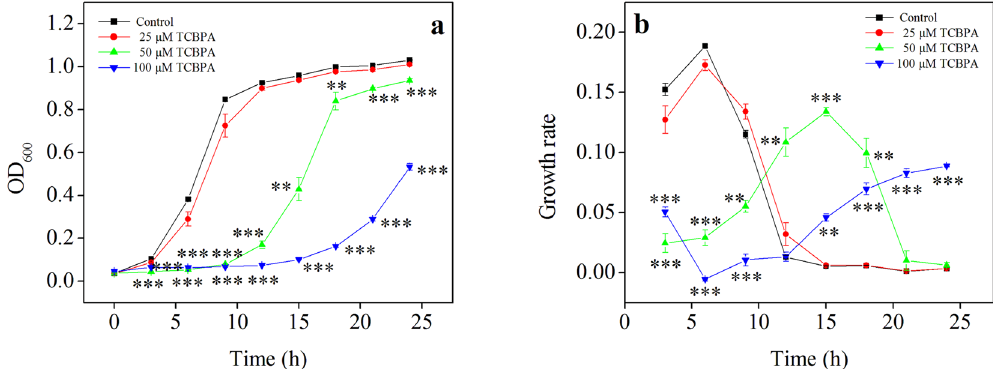
Figure 1. Effect of different concentrations of TCBPA on the growth of S . cerevisiae . ( a ) Growth curve. ( b ) Growth rate. * P < 0.05 compared with the control group; ** P < 0.01 compared with the control group; *** P < 0.001 compared with the control